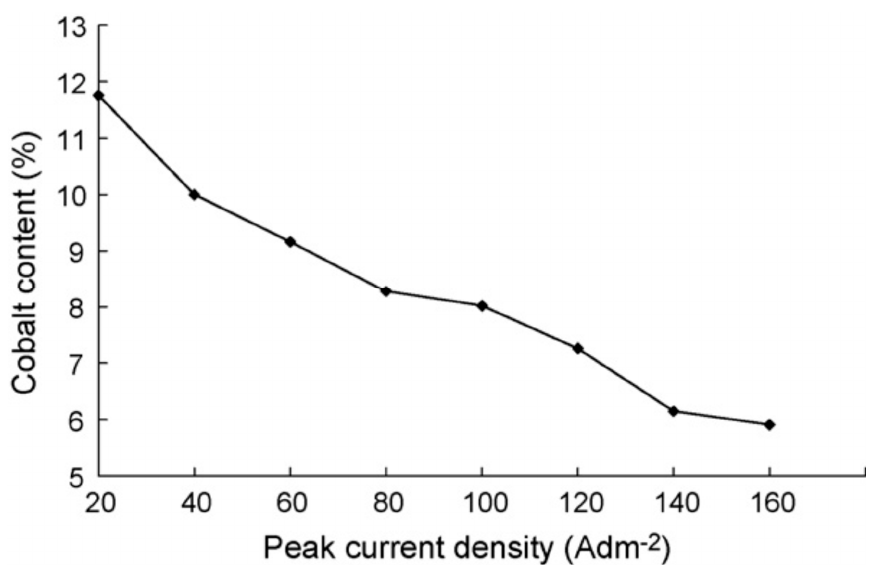
Figure 3. Cobalt content in Ni–Co alloy coatings with varying peak current density [34]. Reprinted